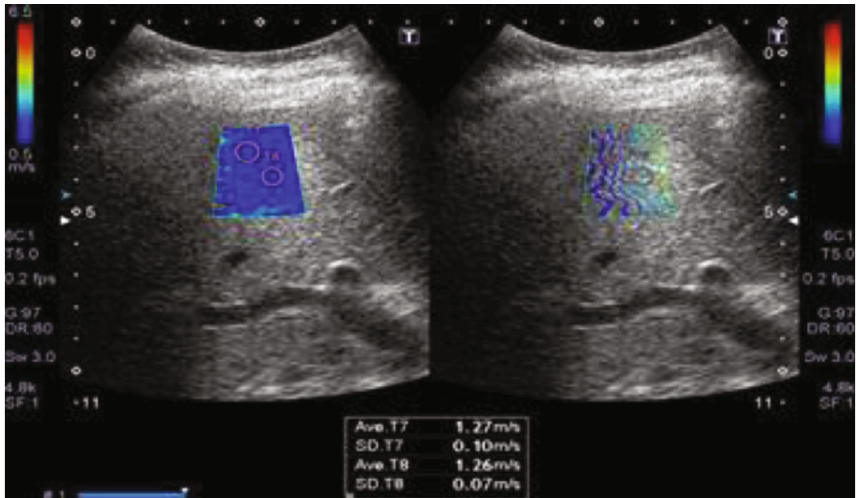
Figure 1: Di ff use hepatic parenchymal disease with F1 METAVIR score expressed as shear wave velocity (1.27